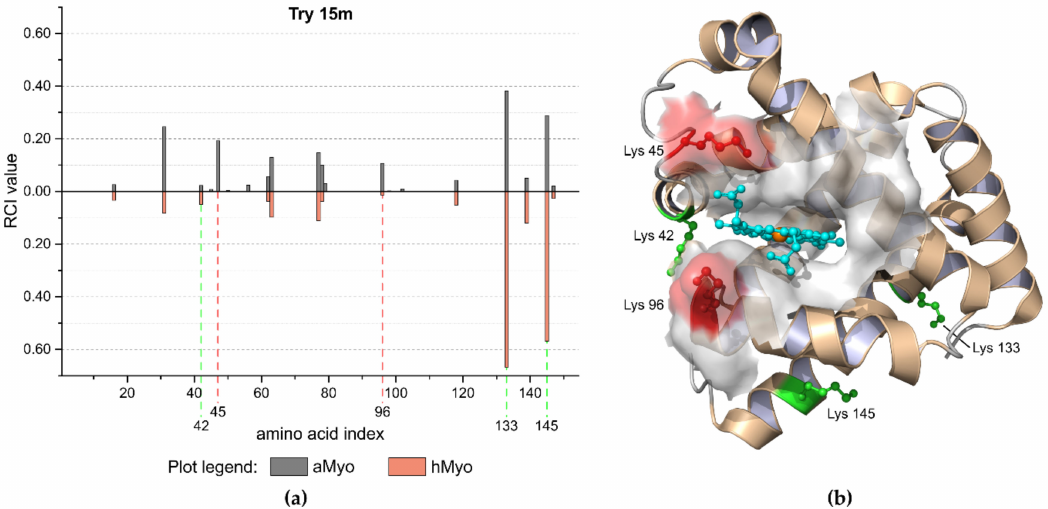
Figure 2. Limited tryptic 15-min proteolysis of aMyo and hMyo forms. ( a ) Butterfly plot visualization of the limited proteolysis experiment for aMyo and hMyo forms. The cleavage sites 42, 133, and 145 were preferentially cleaved in hMyo, whereas sites 45 and 96 were compromised. ( b ) The structure of hMyo with preferred cleavage sites is highlighted in green. The highlighted regions in red color, which include residues 45 and 96, are located close to the heme binding region and are less accessible for protease when heme is present. Heme molecule is highlighted in